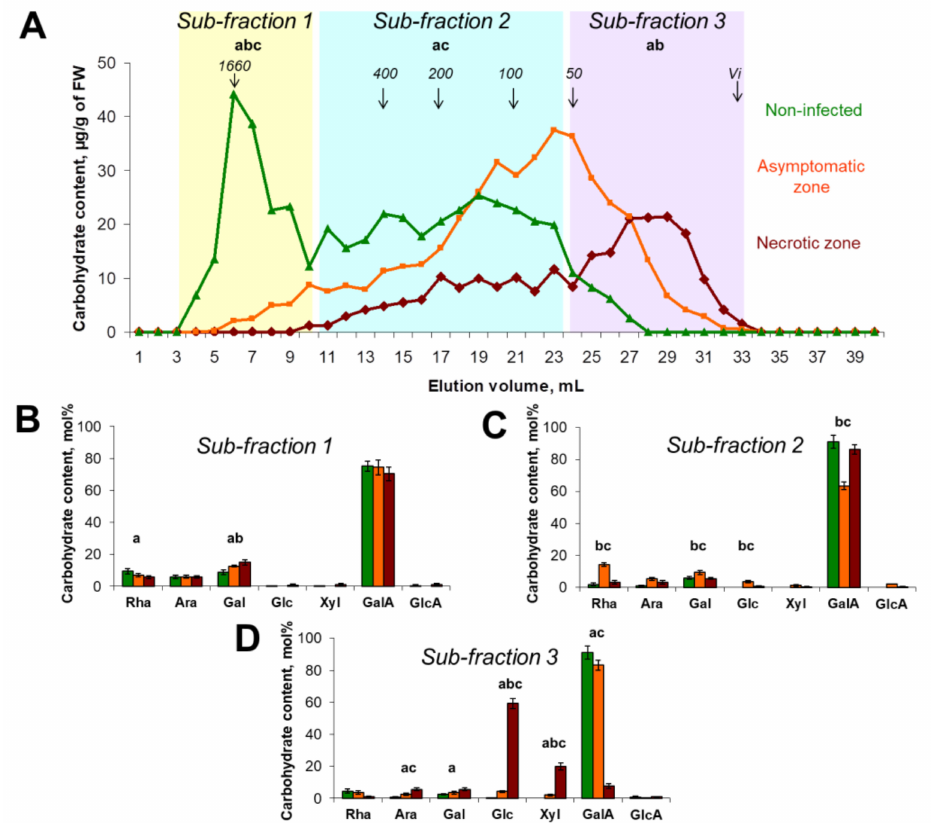
Figure 3. The molecular weight distribution and monosaccharide composition of polysaccharides extracted with 0.5% ammonium oxalate from the plant cell walls isolated from stems of control non-infected (green) or Pectobacterium atrosepticum - infected (orange and brown) potato plants: asymptomatic zone (orange) and necrotic zone (brown). ( A ) Elution profiles were obtained using size-exclusion chromatography on a Sepharose CL-4B column; pullulans were used as molecular weight markers; Vi—inclusion volume; values are the means (per g of fresh weight, FW) of three biological replicates. Monosaccharide composition was analyzed in different sub-fractions, i.e., ( B ) sub-fraction 1, ( C ) sub-fraction 2, and ( D ) sub- fraction 3, which are marked on elution profiles following hydrolyzation with trifluoride acetic acid; values are the means ± SD (mol%) of three biological replicates. Small letters a, b, and c point to the significant difference in the carbohydrate content within a particular sub-fraction (panel A) or in mol% content of a particular monosaccharide (panels B–D)